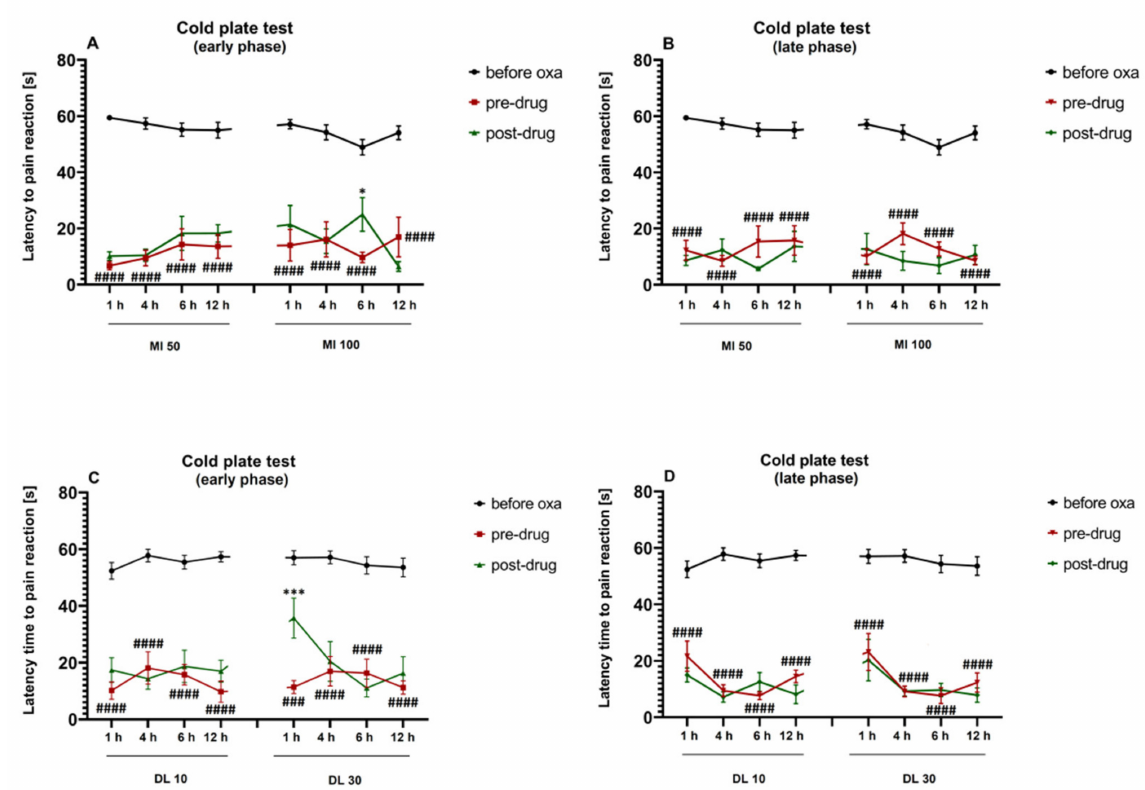
Figure 7. Duration of the antihyperalgesic effect of single-dose minocycline and duloxetine, each used alone, on the pain threshold in oxaliplatin-treated mice. Effect of minocycline (50, 100 mg/kg, i.p.) on cold hyperalgesia measured in the cold plate test assessed 1 h, 4 h, 6 h and 12 h after administration, on the day of oxaliplatin administration ( A ) and 7 days later ( B ). Effect of duloxetine (10, 30 mg/kg, i.p.) on cold hyperalgesia measured in the cold plate test assessed 1 h, 4 h, 6 h and 12 h after administration, on the day of oxaliplatin administration ( C ) and 7 days later ( D ). The results are shown as the mean latency to pain reaction ± SEM for n = 10. Statistical analysis: repeated measures ANOVA followed by Tukey’s post-hoc comparison. Significance: ### p < 0.001, #### p < 0.0001 vs. latency before oxaliplatin; * p < 0.05, *** p < 0.001 vs. pre-drug latency to pain reaction. Abbreviations: MI—minocycline, DL—duloxetine. In the figure titles ‘early phase’ ( A , C ) and ‘late phase’ ( B , D ) mean two time points at which the measurements were taken (day of oxaliplatin administration and day 7 after a single-dose oxaliplatin administration, respectively). Numerical values of the latencies to pain reaction ± SEM presented in this figure are shown in the Supplementary Materials (Table